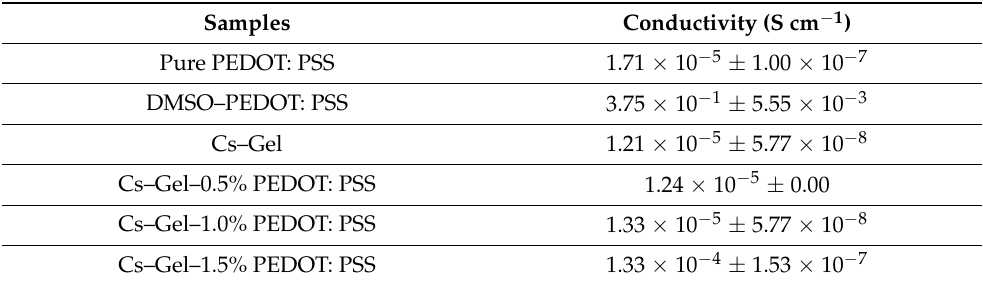
Table 3. The electrical conductivity of solution samples without the addition of agarose in S cm − 1 and S m − 1